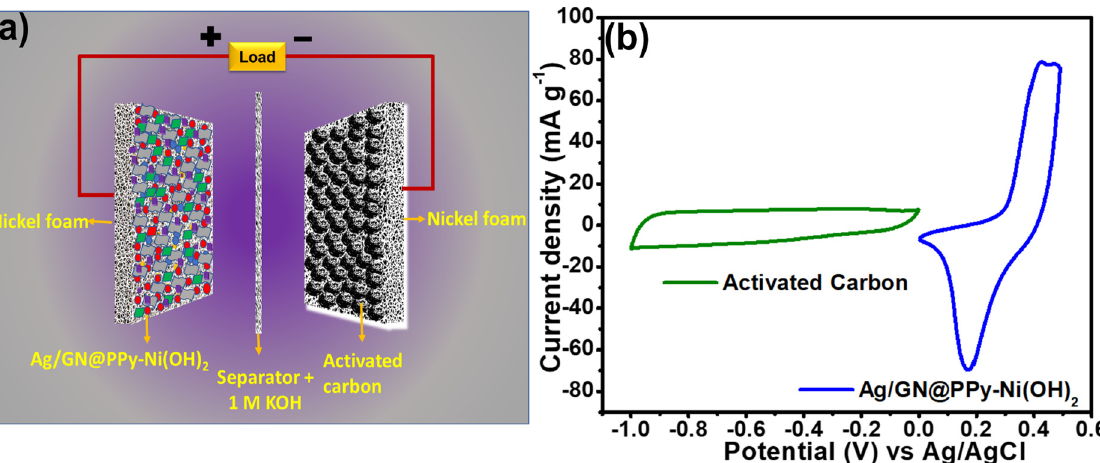
Figure 7. ( a ) Schematic of the constructed supercapattery, ( b ) CVs of AC and Ag/GN@PPy − Ni(OH) 2 electrodes using a standard three electrodes cell system in 1 M KOH at a scan rate of 10 mV s − 1